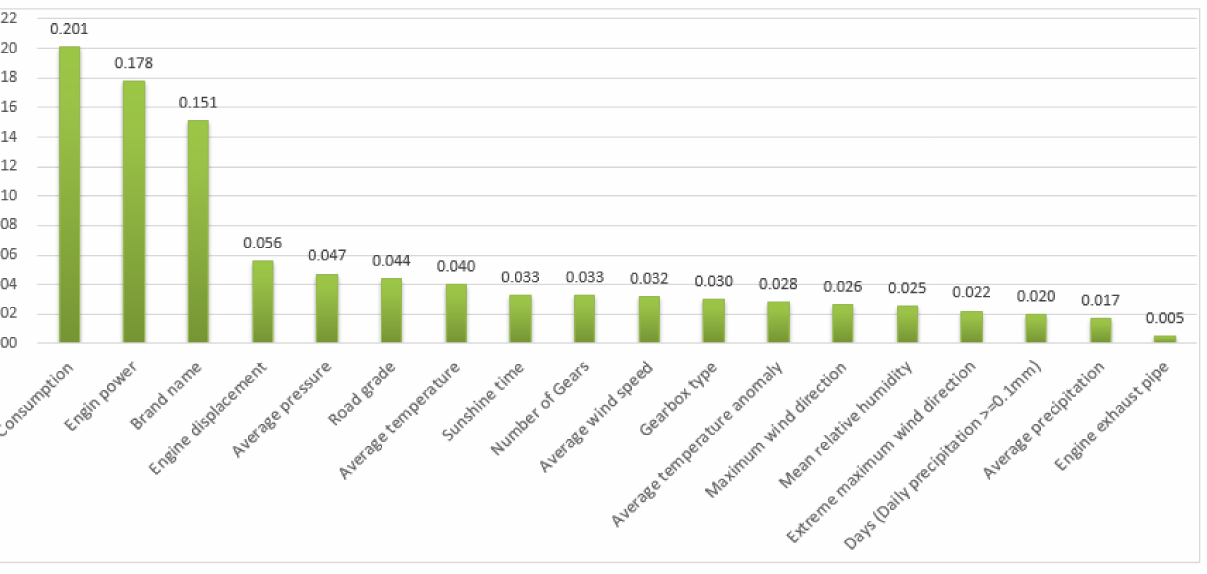
Figure 6. Weights of 18 factors in LightGBM